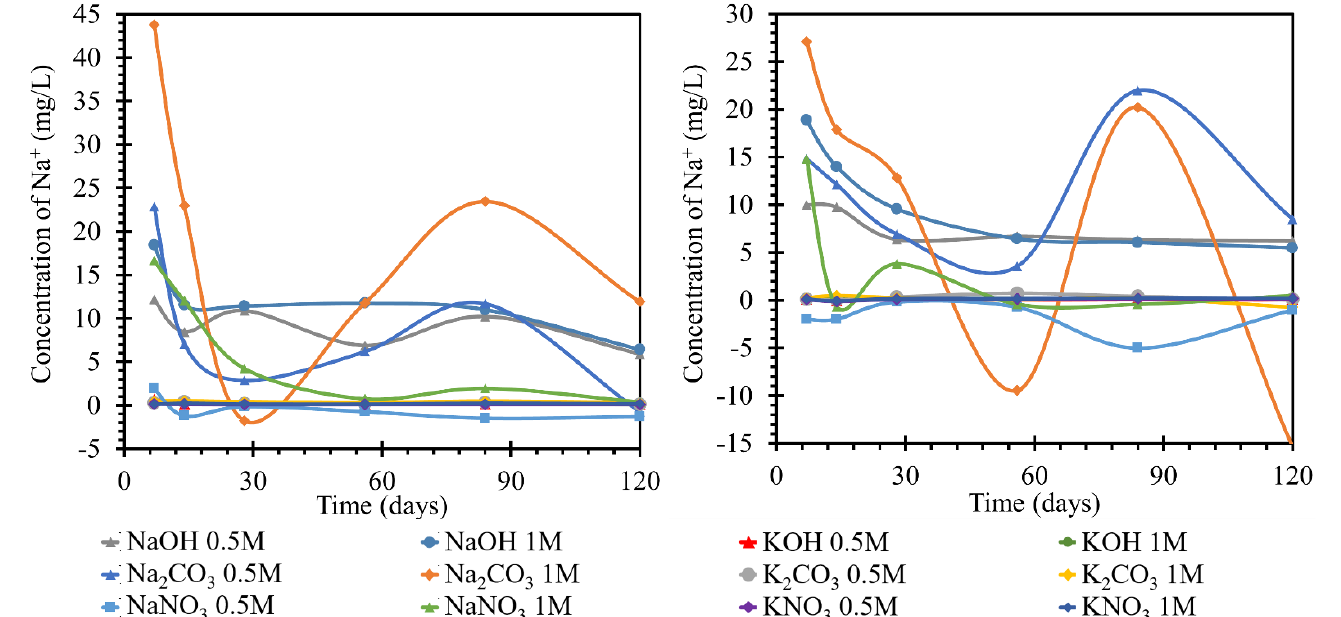
Figure 5. Results of monitoring sodium ion concentrations in individual solutions, on the left at the laboratory temperature of 25 °C, on the right at 40 °C. The Na + concentrations were determined using the ICP − OES method; for clarity, the error bars are not shown, but they reach 1.91% maximum.